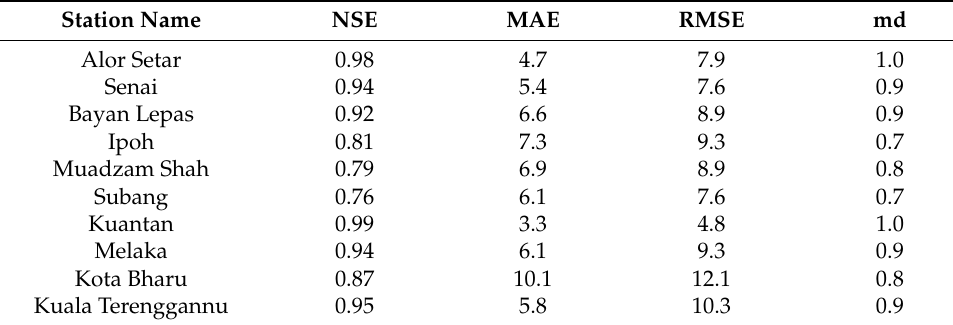
Table 4. Performance of temperature-based ET model developed using